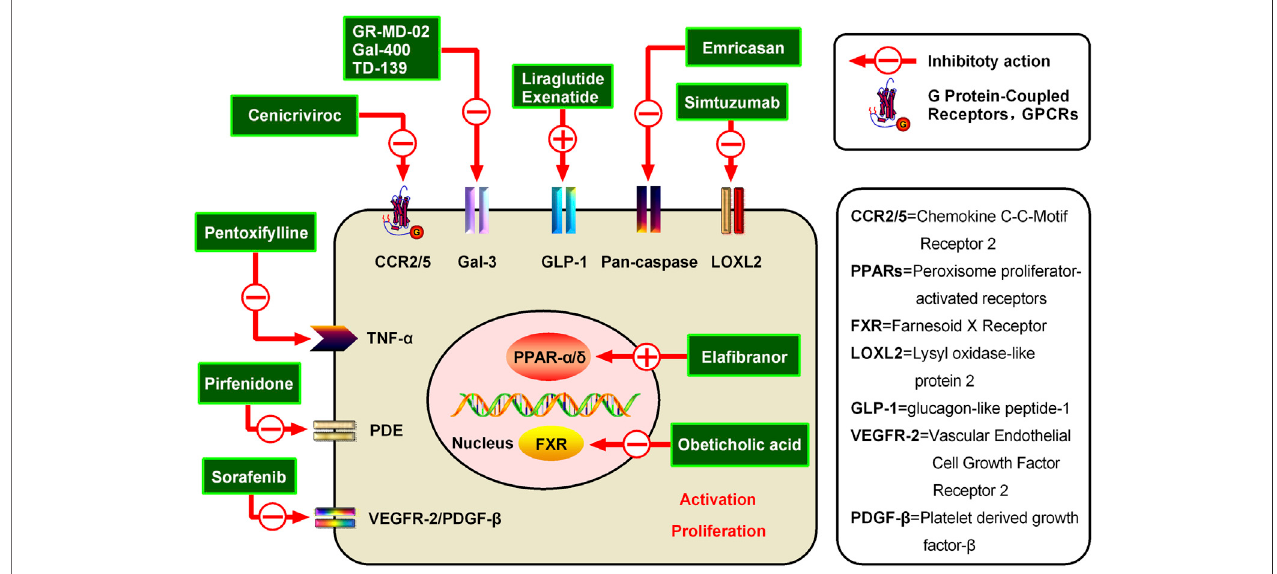
FIGURE 3 | Potential candidates for hepatic fi brosis and their mechanisms of action. Inhibiting the activation and proliferation of HSCs is an important method for the prevention and treatment of hepatic fi brosis. Various representative drugs have emerged for different targets. (1) PPARs are members of the nuclear receptor superfamily, and the PPAR agonist Ela fi branor can inhibit liver fi brosis through direct anti-in fl ammatory effects and indirect improvement of the oxidative stress state. (2) Additionally, a representative FXR receptor agonist, Obeticholic acid, has been shown to reduce liver in fl ammation and promote ECM degradation to alleviate hepatic fi brosis. (3) Simtuzumab is a monoclonal antibody currently being developed by Gilead for NASH, cirrhosis, and advanced hepatic fi brosis blocking of LOXL2. LOXL2isaproteasethatmodi fi estheECMbypromotingthecross-linkingofcollagen fi bersandisbelievedtoplayanimportantroleintumorprogressionand fi brosis.(4) Emricasanisanirreversiblepan-caspaseinhibitor,whichcanreducetheactivityofcaspasestoimprovethein fl ammatoryenvironmentandinhibitHSCactivation.(5)The GLP-1R agonist Liraglutide can inhibit the formation of ECM and reduce the liver in fl ammatory response and fi brosis process. (6) Belapectin is a galectin-3 antagonist, which can alleviate hepatic fi brosis and portal hypertension in rats and was found to be safe and well-tolerated in a phase I trial. (7) The CCR2/5 antagonist Cenicriviroc can improve hepatic fi brosis by inhibiting liver in fl ammation. Cenicriviroc is not only effective for early hepatic fi brosis but also feasible for maintenance treatment in patients with advanced fi brosis. (8) Pentoxifylline is a non-speci fi c PDE inhibitor, which can increase intracellular cAMP concentration and plays an anti-hepatic fi brosis role by inhibiting TNF- α production. (9) Attenuating TGF- β -induced signal transduction pathways can inhibit hepatic fi brosis, such as via Pirfenidone (10) Sorafenib can inhibit VEGFR-2 and PDGF- β to alleviate hepatic fi